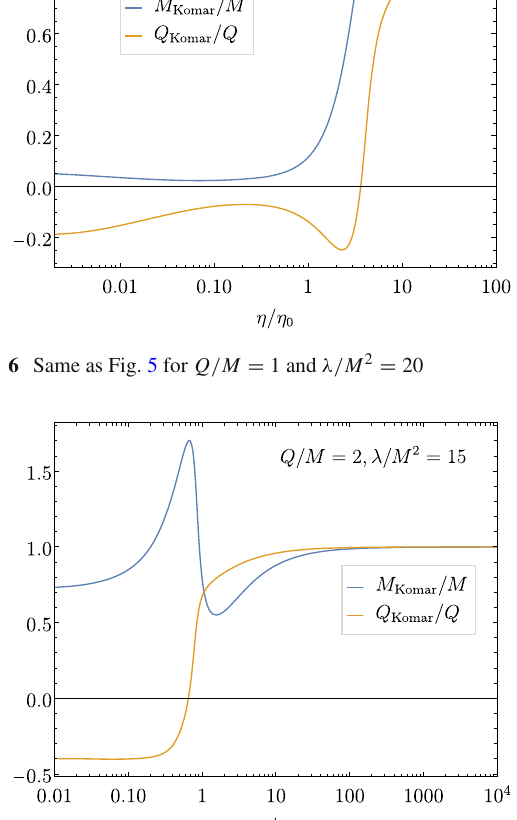
tinued to infinity and must be discarded. The onset of the cusp-singularity is marked by a long-dashed black curve.